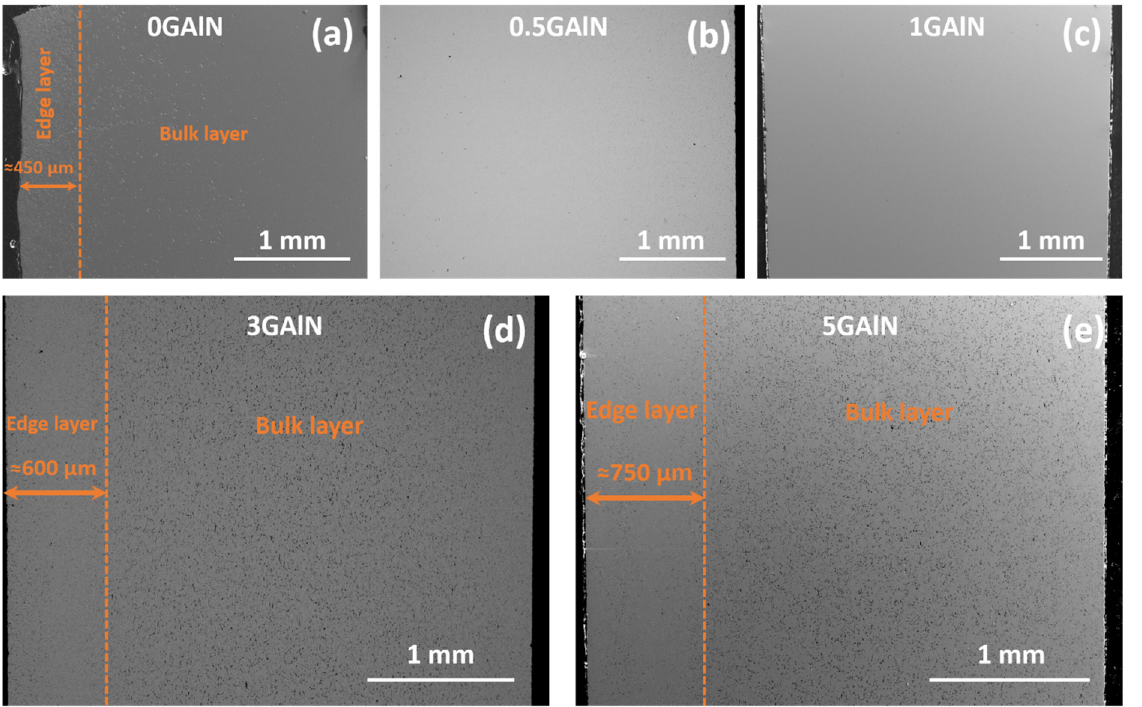
Figure 5. Scanning electron microscopy images of the sintered YSZ/GAlN composite ceramics: ( a ) 0 GAlN, ( b ) 0.5 GAlN, ( c ) 1 GAlN, ( d ) 3 GAlN, ( e ) 5 GAlN. Magnification 70×.